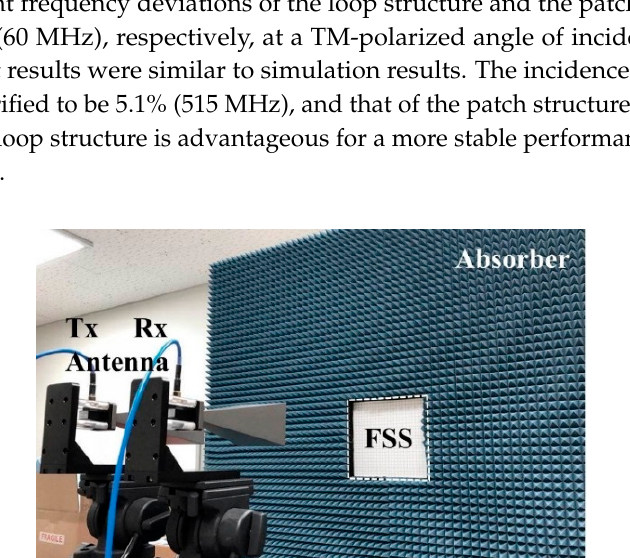
Figure 4. Fabrication FSS on paper: ( a ) Loop type; ( b ) Patch type.